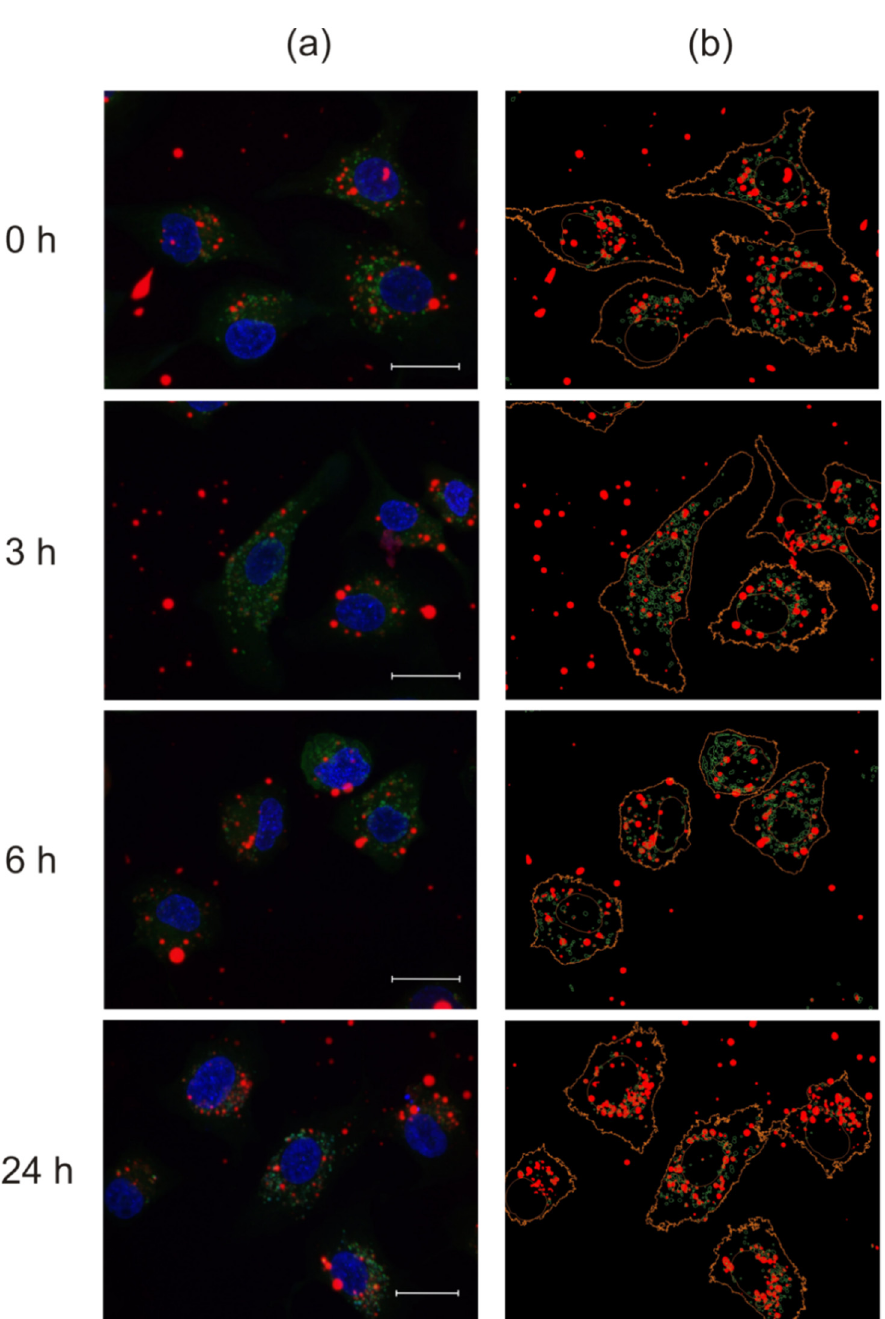
Figure 5. Localization of the fluorescent RL2 2 conjugate (fRL2) in A549 cells. ( a ) The microscopy analysis. Scale bar, 20 µ m. Regions of the intranuclear localization of Hoechst 33342 are blue, regions of fRL2 localization are red, lysosomes and endosomes with pH below 5.5 are green. ( b ) Colocalization analysis (Table S2). Orange lines denote cell edges and nuclei, green lines indicate lysosome and endosome edges, and red signals are fRL2